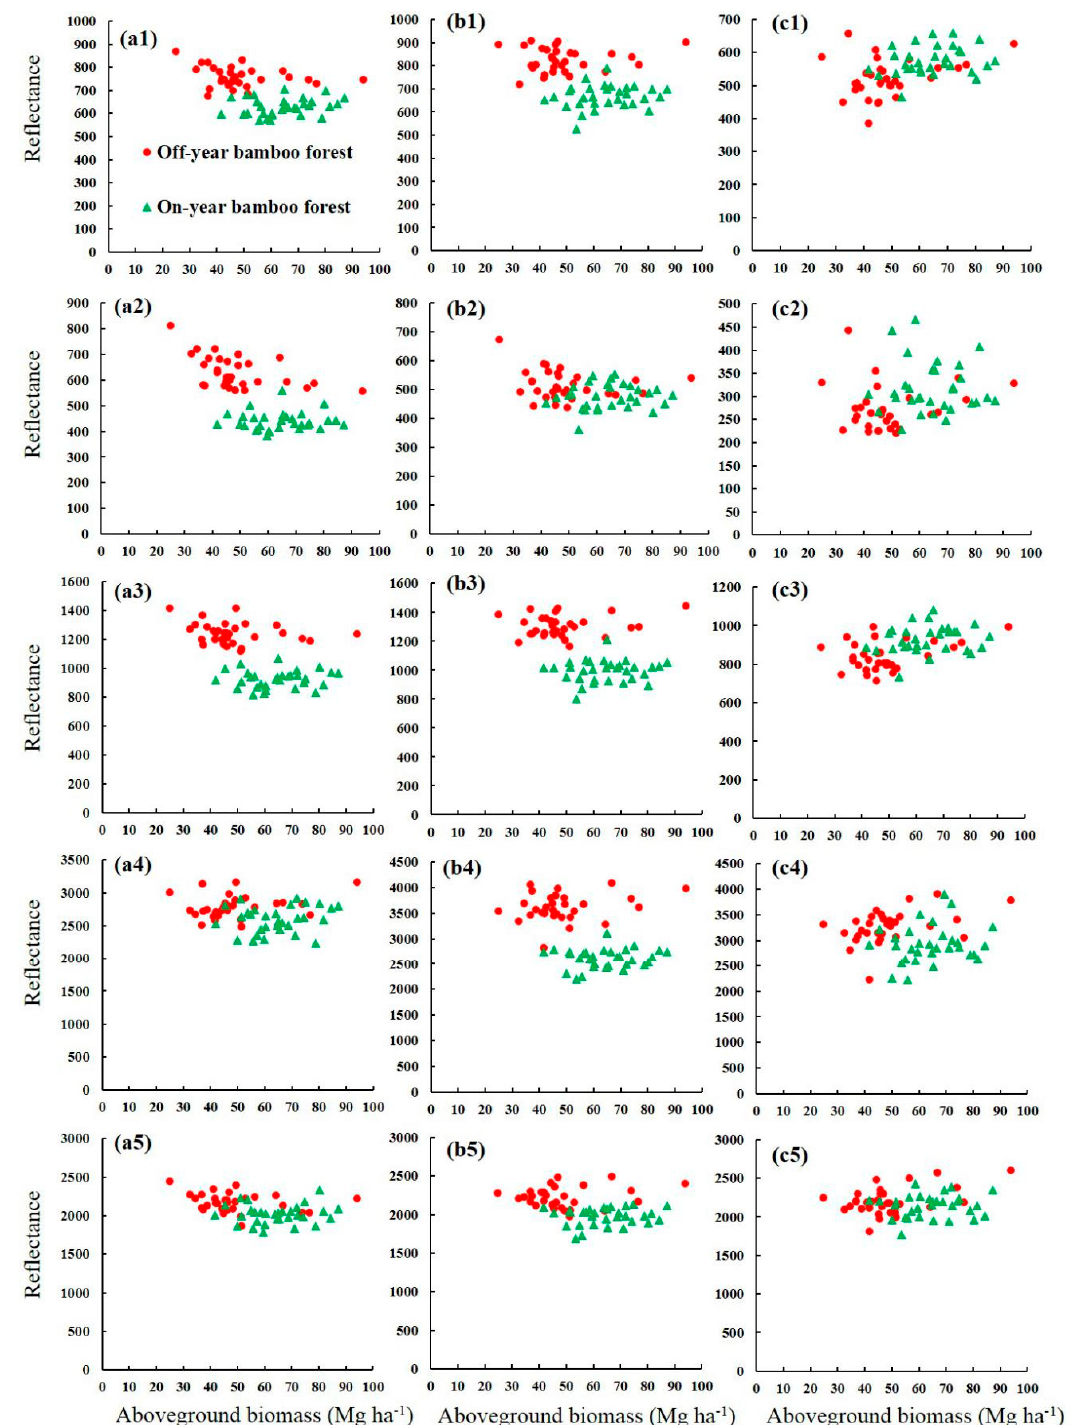
Figure 7. The scatterplots between spectral bands and biomass (( a ), ( b ), and ( c ) represent April, May, and July, respectively; 1 , 2 , 3 , 4 , and 5 represent green, red, RedEdge1, NIR1, and SWIR1spectral bands,